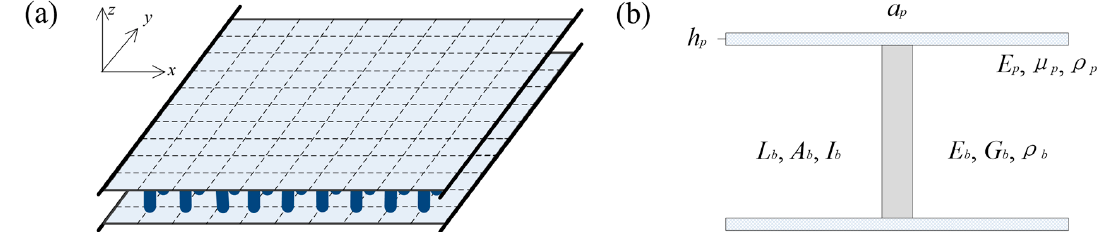
Figure 1. The metamaterial sandwich plate with axially deformed beam cores. ( a ) The 3D view, and ( b ) the unit-cell.